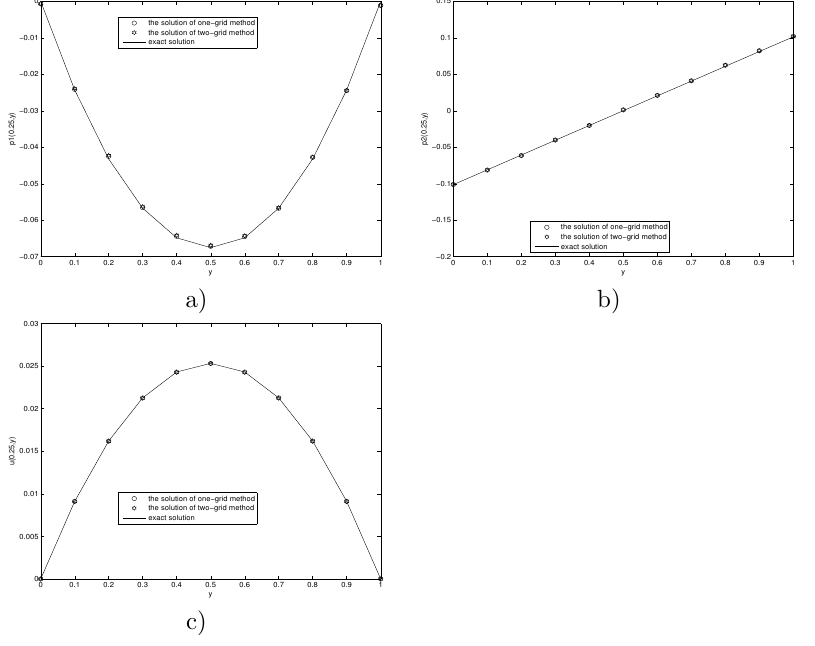
Figure 3. Numerical solutions and exact solutions for ν = 1. (a) the solutions of p 1 , (b) the solutions of p 2 , (c) the solutions of u .